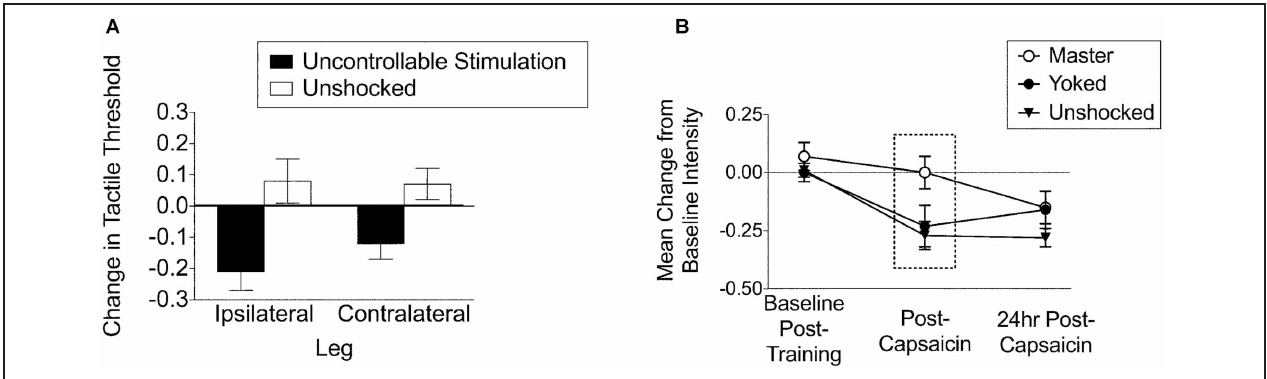
FIGURE 2 | Training history alters nociceptive hyper-reactivity. (A) Uncontrollable stimulation (6min, 80ms stimuli, variable inter-stimulus interval: 0.8–3.2 s, 1.5mA AC) to the leg produces tactile hyper-reactivity on both the ipsilateral and contralateral leg. The same stimulation pattern undermines spinal cord learning on both leg for over 24h and impairs recovery of locomotor function for over 6 weeks (adapted from Ferguson